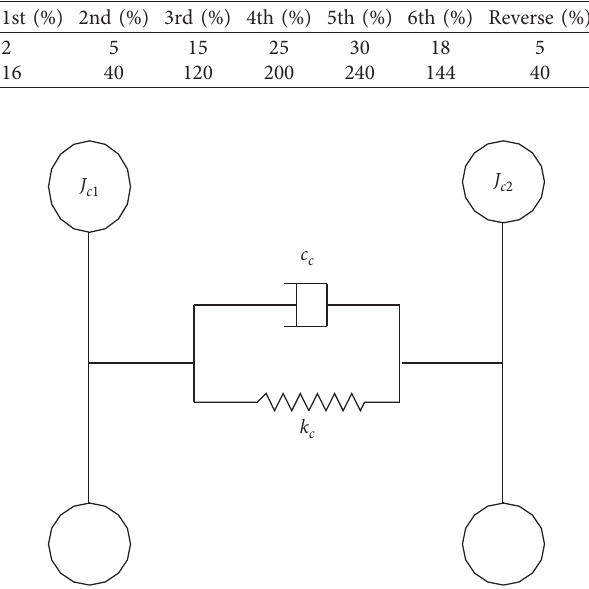
Figure 2: Dynamics model of Geislinger